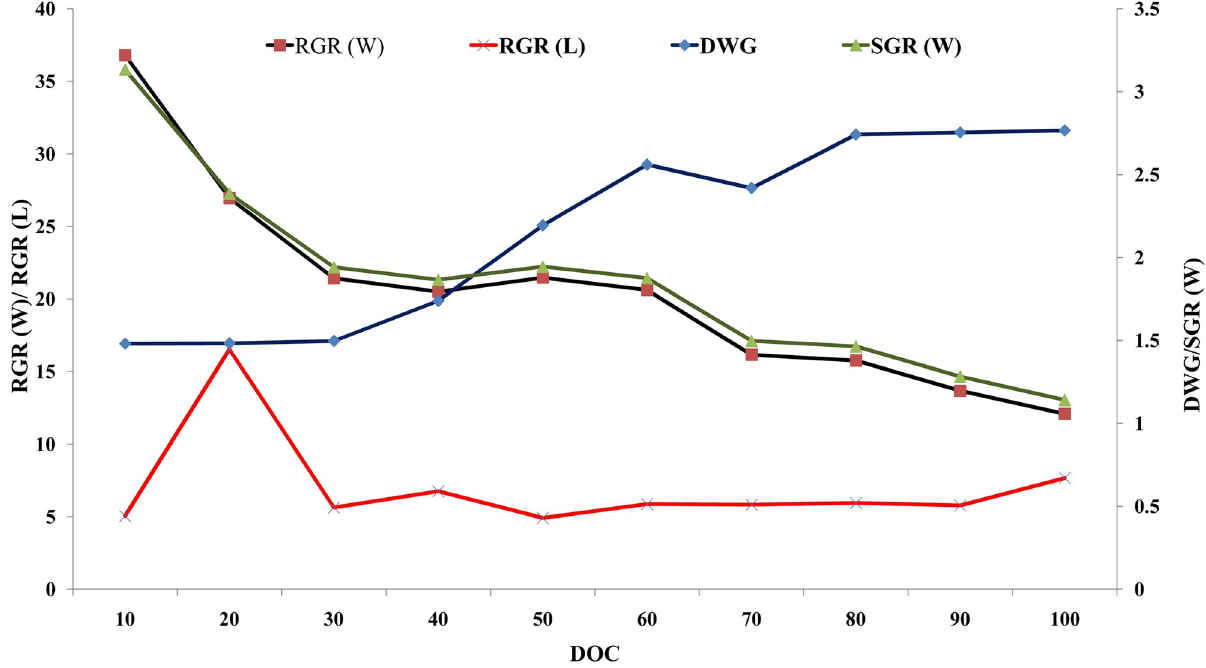
Fig 2. Temporal variation of growth indices across the grow-out culture